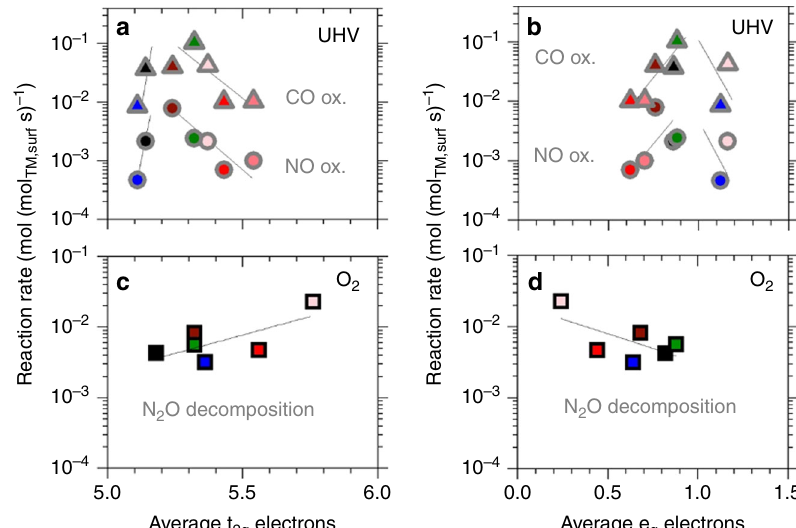
Fig. 4 Correlations of catalytic rates and d -orbital occupancy. a , b Dependence of reaction rates in CO oxidation (triangles) and NO oxidation (circles) on average number of electrons in TM t 2g or e g orbitals measured in ultrahigh vacuum (UHV). c , d N 2 O decomposition rates as a function of t 2g or e g orbital occupancy in 0.37 kPa O 2 . Symbol edge color identi fi es F cov in O 2 presence (black) or UHV (gray). Fill colors represent the substituent cation in LaCoO 3 (no substituent: black fi ll): Ni (green), Zn (blue), increasing Al fraction (dark to light red). Lines represent least squares fi ts of the full set or subset of data.